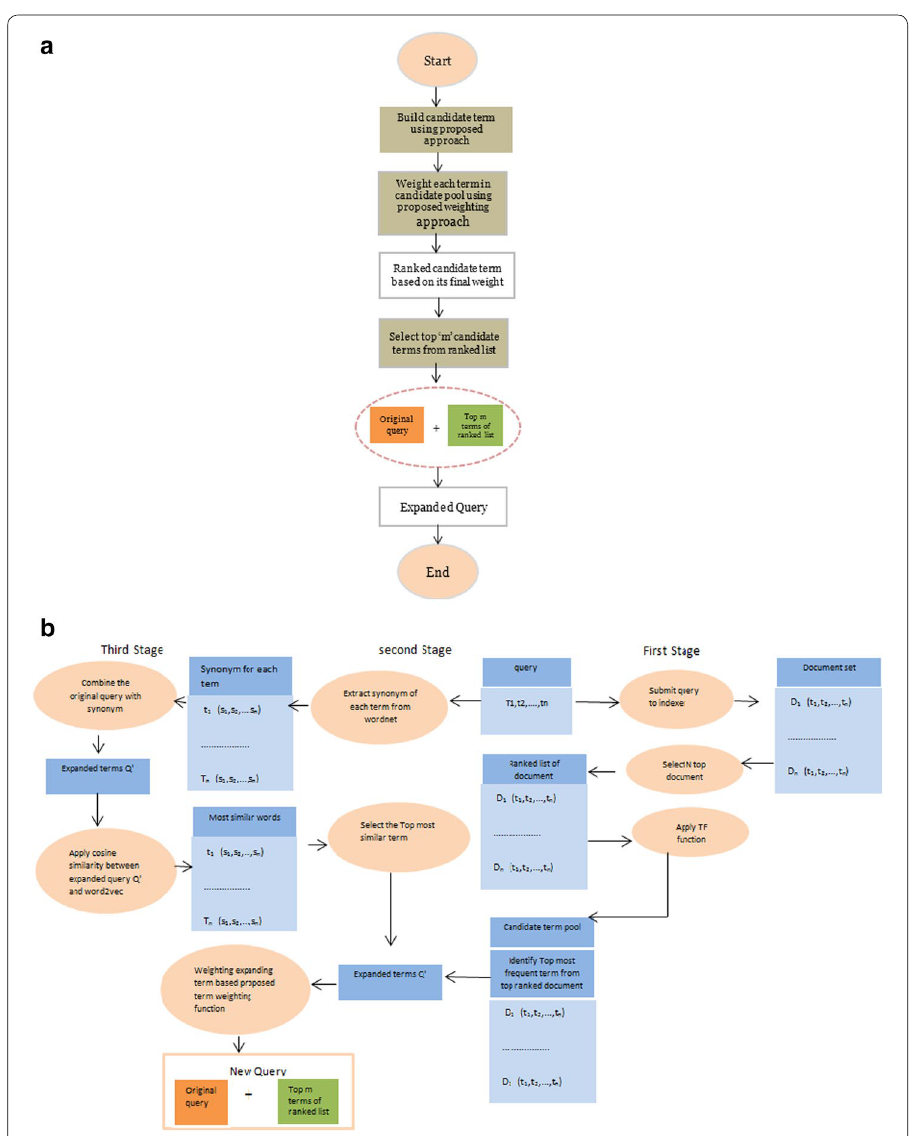
Fig. 1 Overall architecture for the proposed